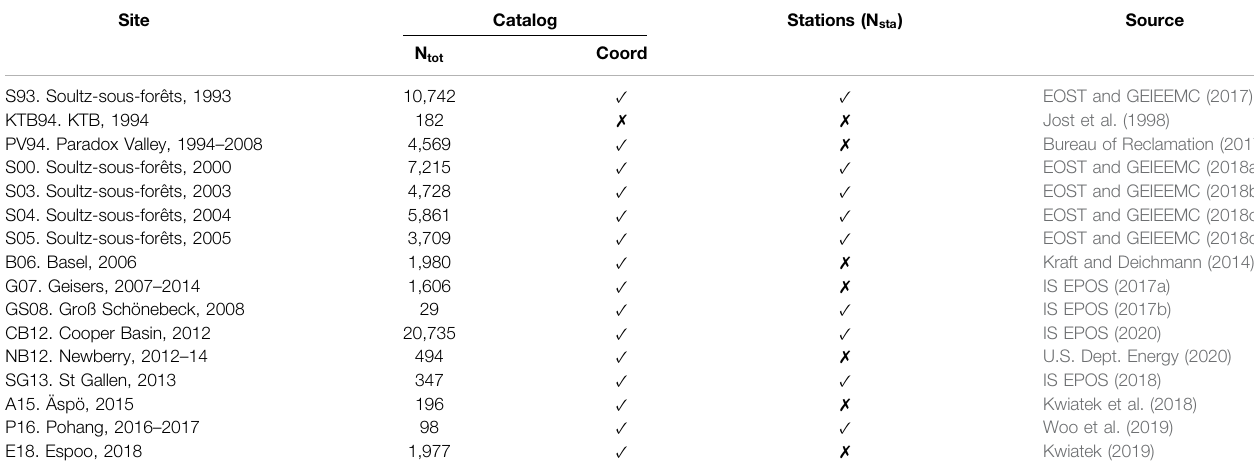
TABLE 1 | Available public data for induced seismicity completeness analysis.